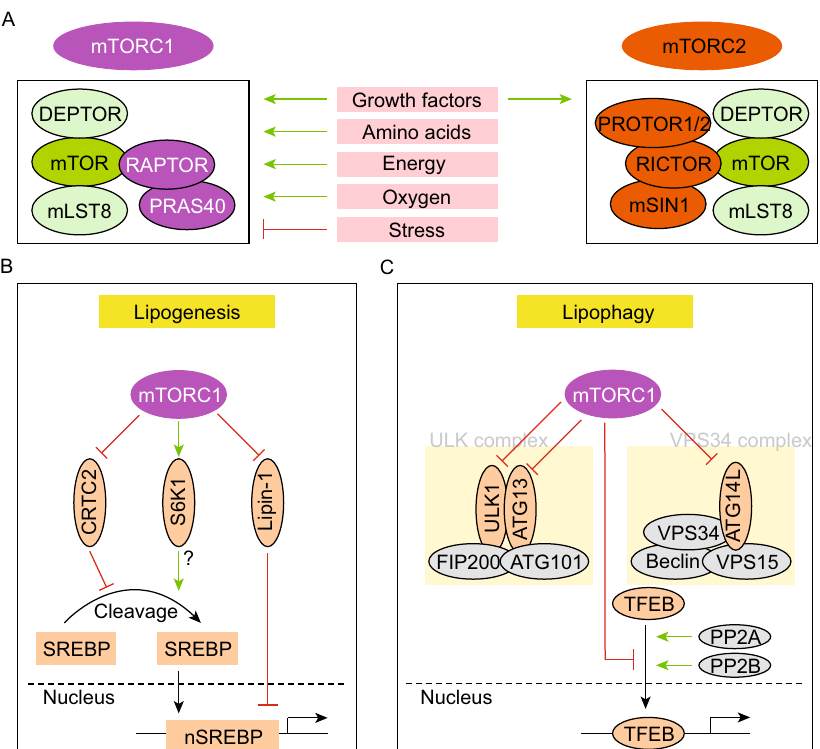
Figure 1. mTOR signaling in hepatic lipid metabolism. (A) The protein composition and key features of mTORC1 and mTORC2. mTORC1 responds to growth factors, amino acids, stress, oxygen and energy, while mTORC2 only responds to growth factors. (B) mTORC1 promotes SREBP-dependent lipogenesis through the phosphorylation of CRTC2, S6K1, and Lipin-1. (C) mTORC1 inhibits lipophagy by blocking autophagy initiation and attenuating lysosome